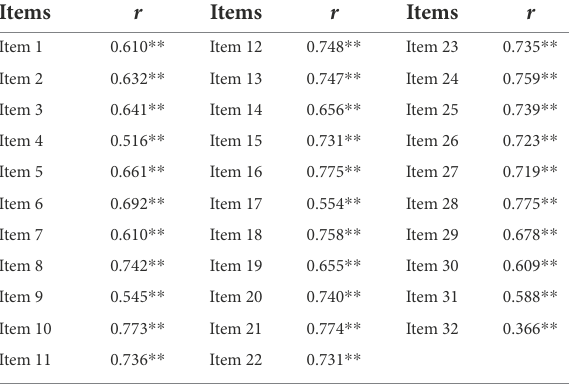
TABLE 3 Results of the Pearson’s correlation coefficient analysis.